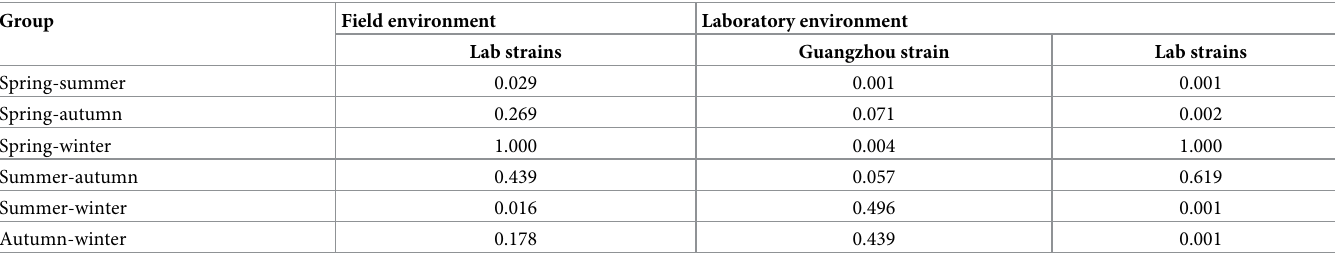
Table 2. P values for pairwise comparison of four seasonal emergence rates in different experimental groups.